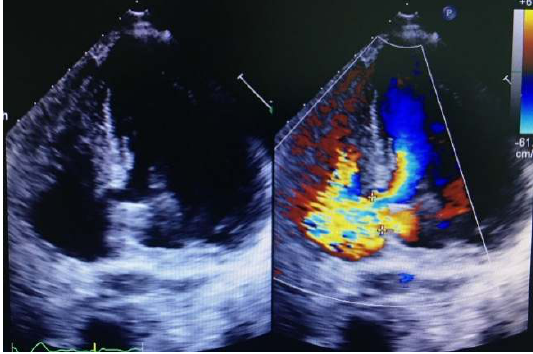
Figure1: Pre-operative transthoracic echocardiogram shows a ventricular septal rupture with left-to right shunt flow.